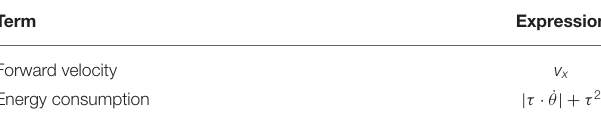
TABLE 5 | Reward terms. TABLE 6 | Performance constraint costs.